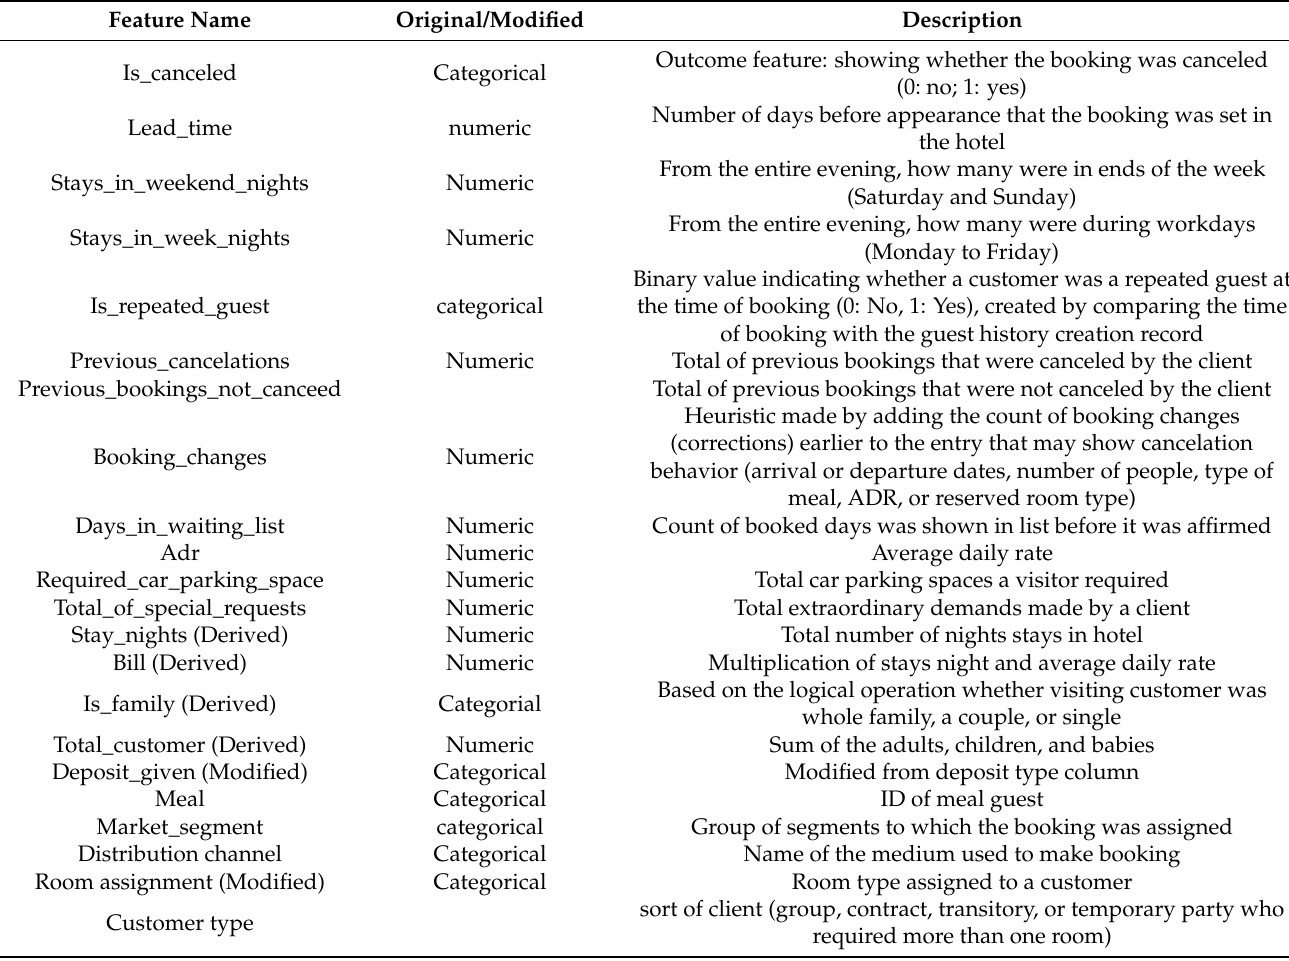
Table 1. Description of feature column after feature selection and